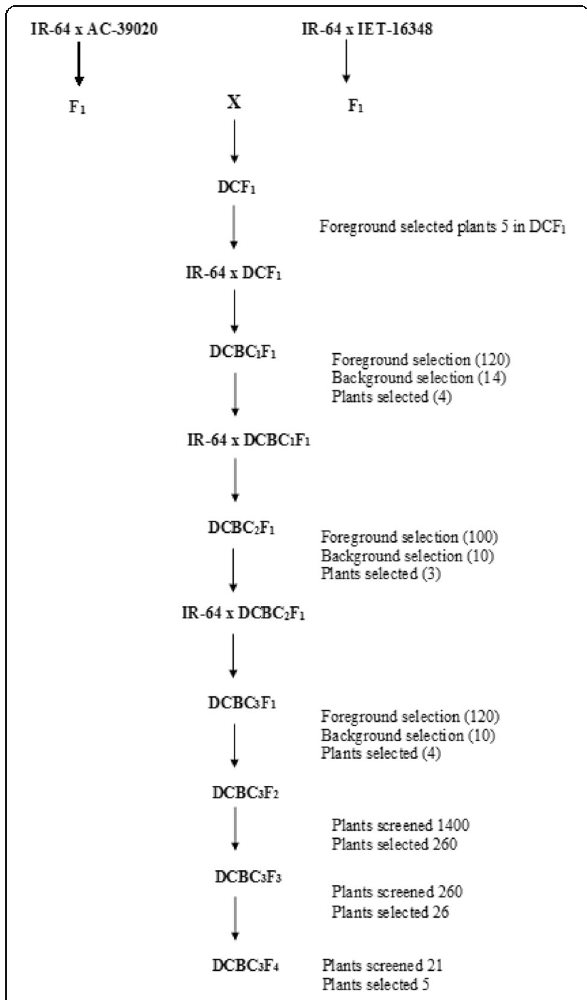
Fig. 1 The scheme of Multi-parent Marker-assisted backcrossing (MABC) to introgress root and WUE traits into IR-64 background. Foot note: Based on phenotypic and molecular diversity AC-39020 and IET-16348 were selected as donor parents for root WUE associated traits. IR-64 was selected as recipient parent because of its drought susceptibility. The donor parents were hybridised with recipient parents separately, to obtain the F 1 s. The resultant F 1 s were hybridised to get DCF 1 s. From this stage, plants were selected and backcrossed with IR-64 till BC 3 F 1 stage. Further, selfing was done to identify the trait introgressed